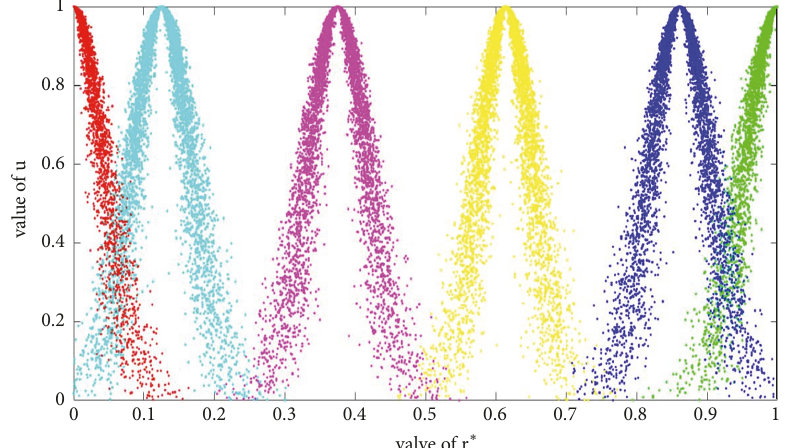
Figure 4: The standard cloud map of the